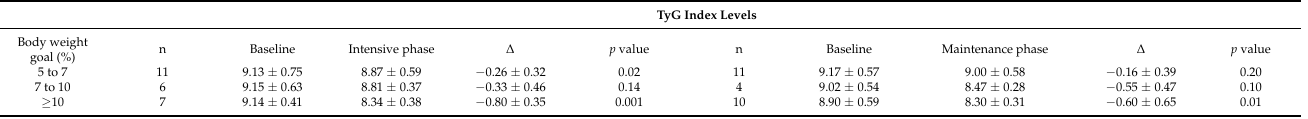
Table 3. Comparison of TyG index levels by body weight loss stratum. TyGIndexLevels